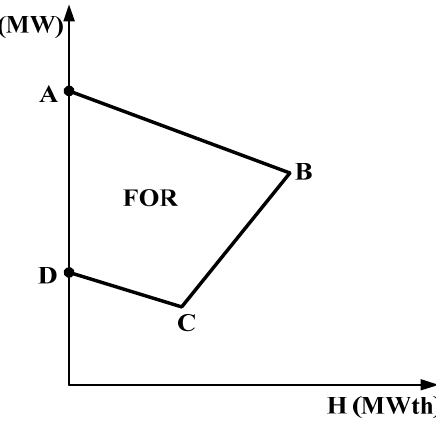
Figure 1. FOR of a CHP unit .